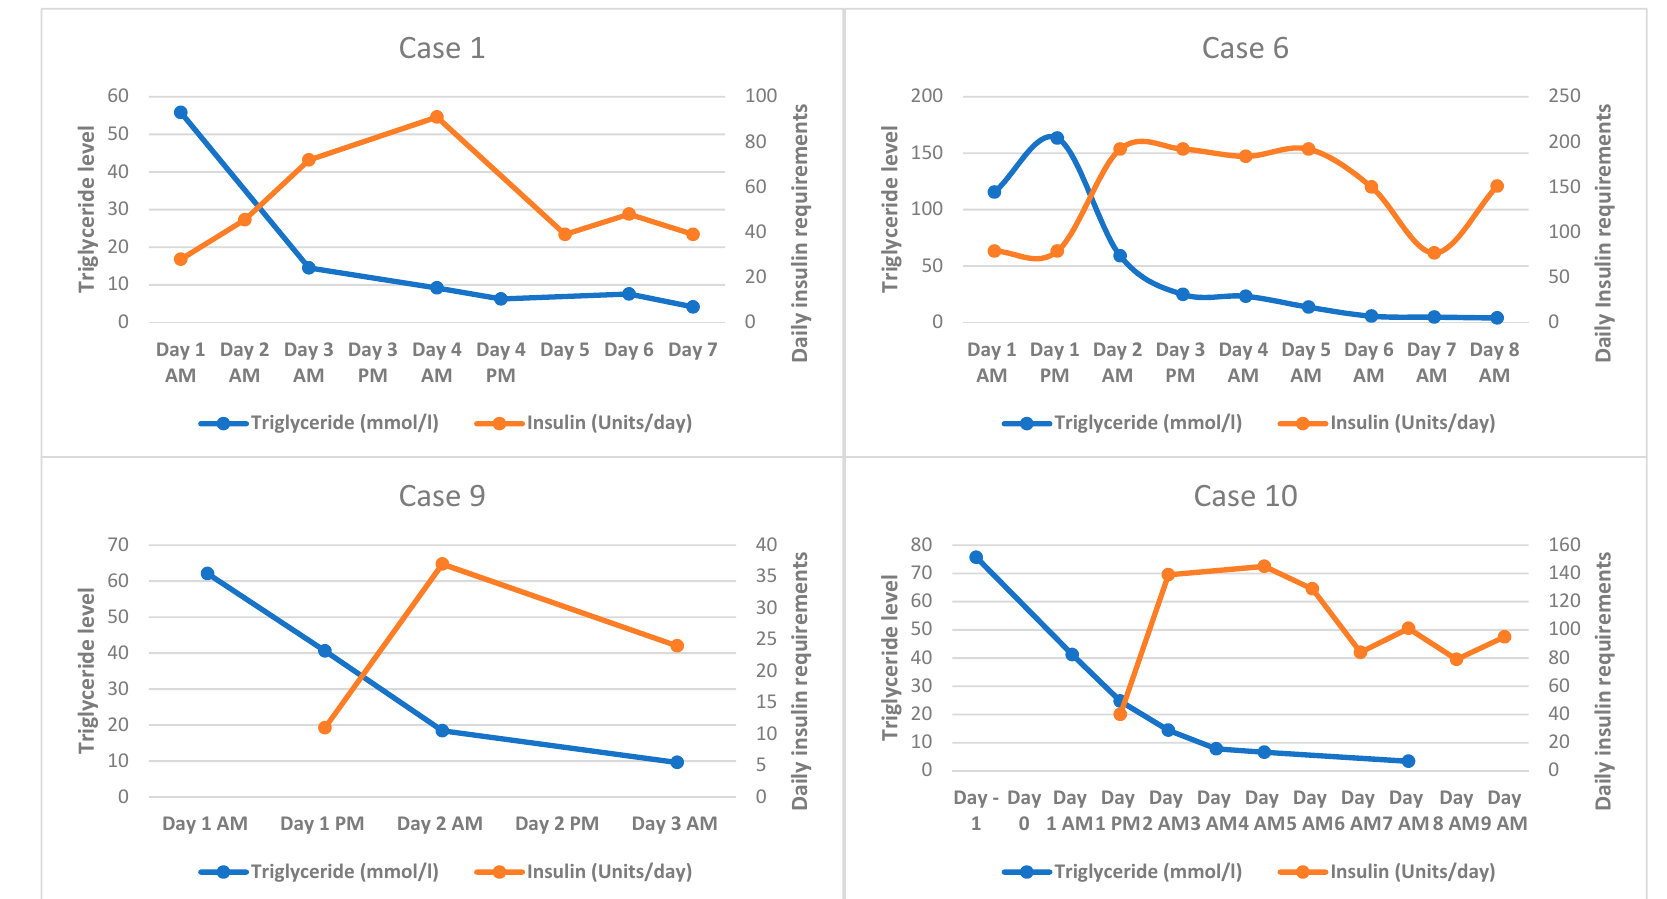
Figure 2. Triglyceride trends with insulin therapy. Case 1: Intravenous insulin infusion of 4 units/h (0.05 units/kg/h), then transitioned to subcutaneous insulin on Day 4. Case 6 : Intravenous insulin infusion of 8 units/h (0.1 units/kg/h) and required 10% dextrose infusion due to hypoglycemia. Transitioned to subcutaneous insulin on Day 7. Case 9 : Intravenous insulin infusion of 2 units/h (0.02 units/kg/h). Insulin ceased completely on Day 3 as no known diabetes (HbA1c 38 mmol/mol, 5.6%). Case 10 : Intravenous insulin infusion of 8 units/h (0.1 units/kg/h), then transitioned to subcutaneous insulin on Day 7.